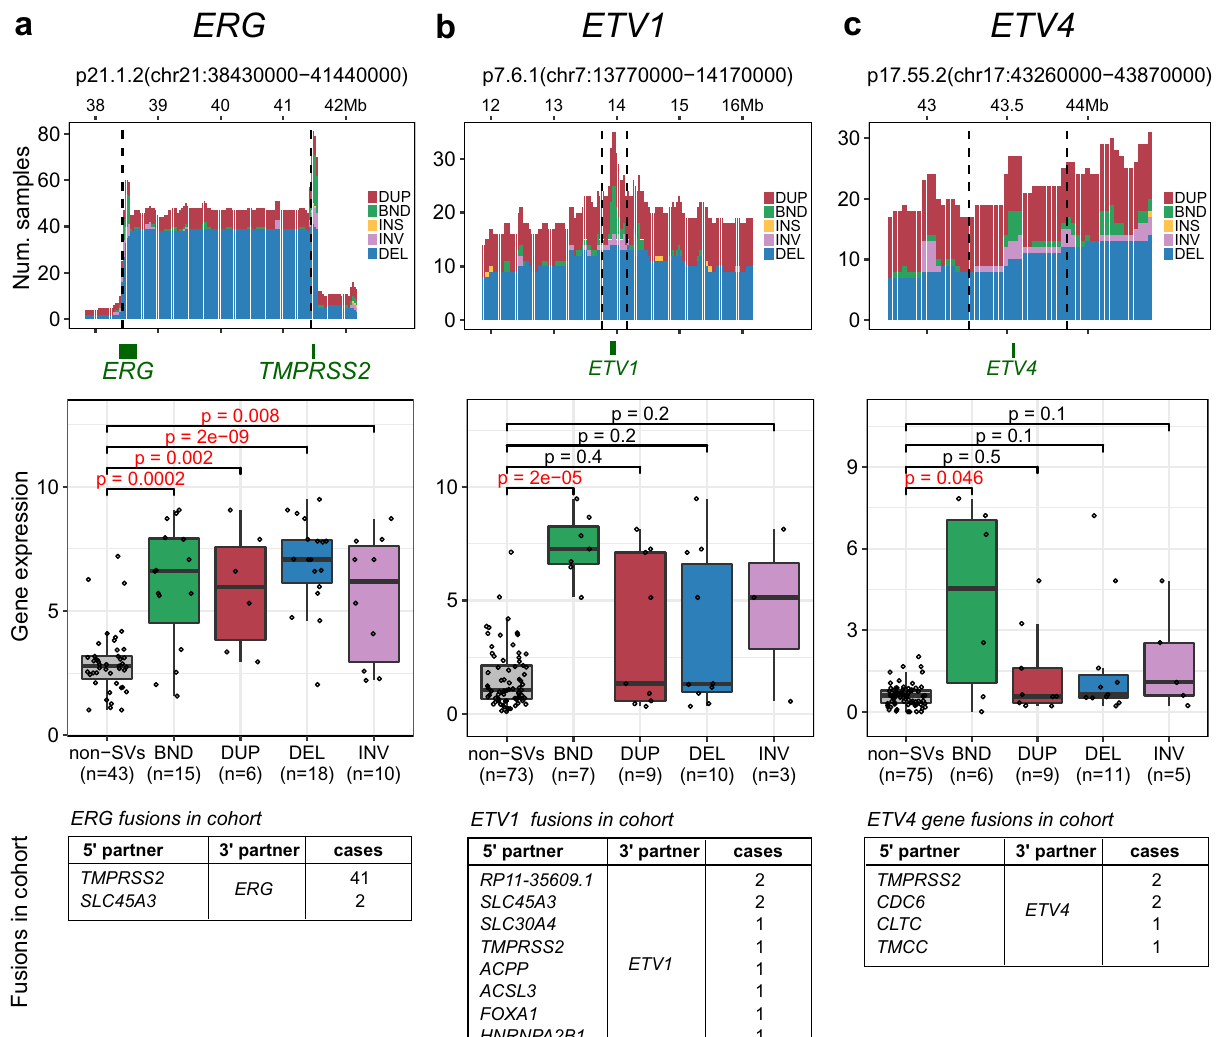
Figure 5. SV-HotSpot detects recurrent deletions and translocations corresponding to the ETS family gene fusions. From left to right are results for ERG ( a ), ETV1 ( b ) and ETV4 ( c ) . In each panel, from top to bottom are (1) stack histogram of sample counts for different types of SVs within the peak (bounded by black dashed lines), (2) comparison of expression of the gene between samples harboring individual SV types and those without any SVs (restricted to samples whose gene is copy neutral), and (3) list of gene fusions in cohort whose 3 ′ partner is the gene (not part of SV-HotSpot visualization). ERG hotspot is enriched for deletions corresponding to TMPRSS2-ERG fusions and translocations including those that create —ERG fusions with different 5 ′ partners, all associated with increased ERG expression. ETV1 and ETV4 peaks were enriched for translocations corresponding to various fusions and associated with increased gene expression. Note that we used expression of ERG , ETV1 , and ETV4 from the original publication that was normalized using the full length genes, and thus could be lower than the true fusion expression. This does not change our conclusion as the actual effect of translocations on fusion expression could be